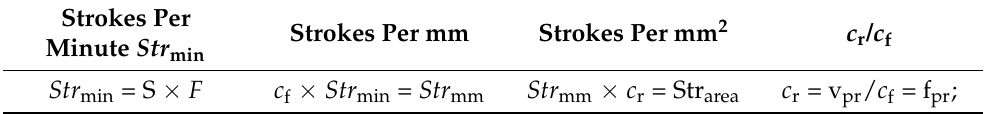
Table 2. Equations and relations for cf and cr.